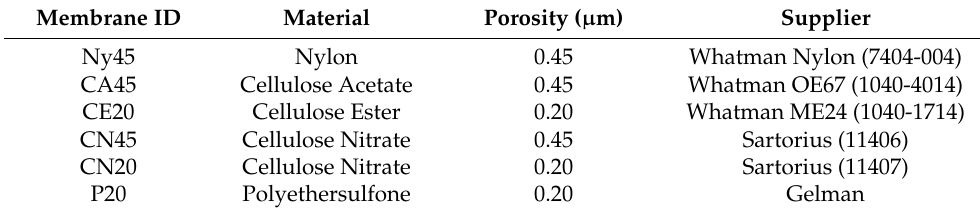
Table 1. Tested hydrophilic membranes and their characteristics.